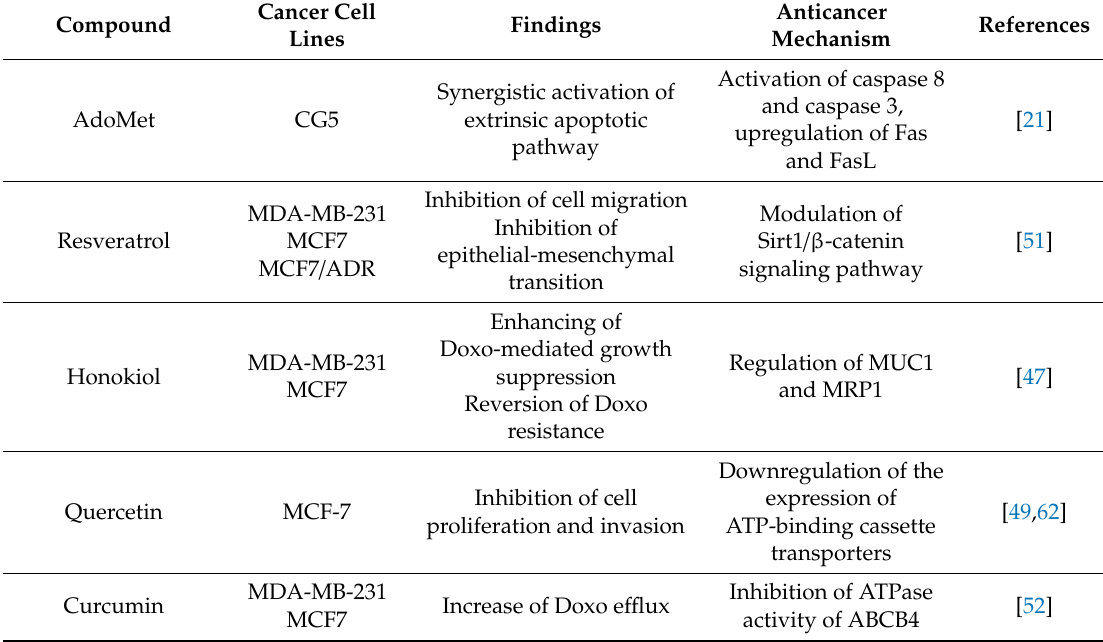
Table 1. E ff ect of AdoMet and emerging phytochemicals in combination treatment with Doxo in breast